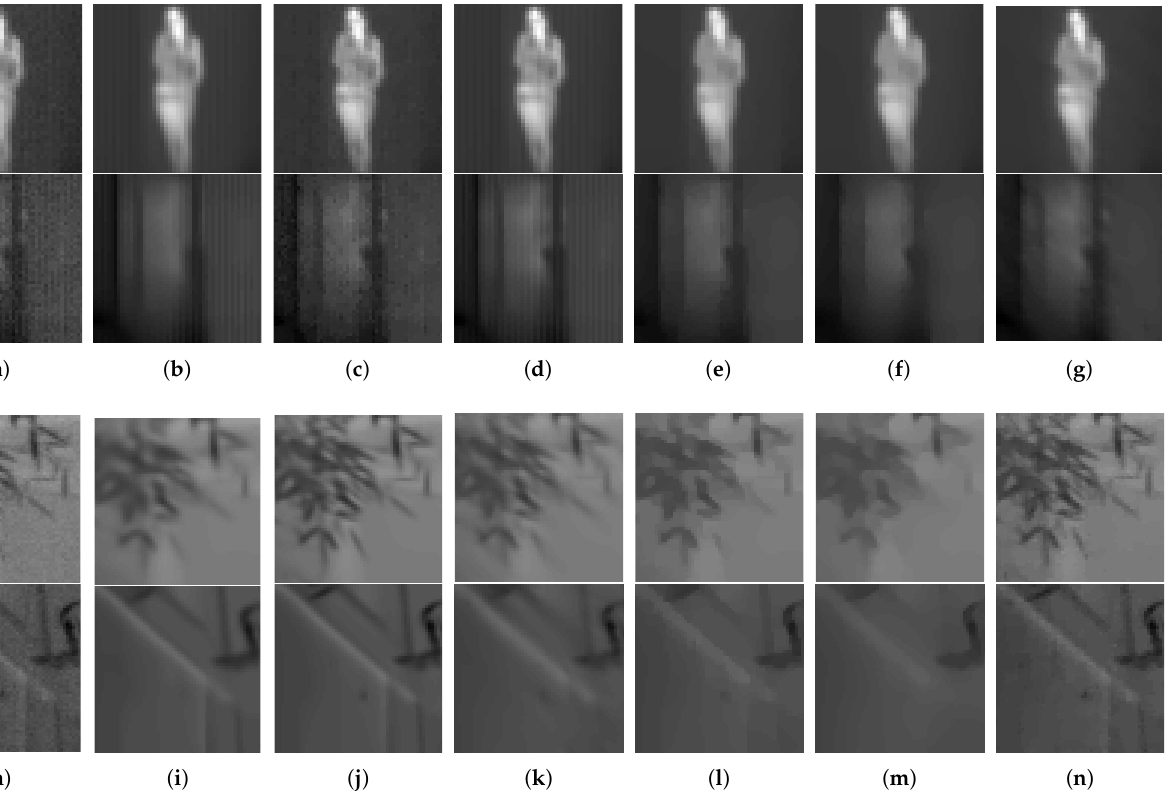
Figure 10. Final results of the conventional and proposed method. ( a , h ) Original degraded image of MORRIS ( top ) and KRISTO dataset ( bottom ); ( b , i ) BM3D; ( c , j ) Ochs et al.; ( d , k ) TWSC; ( e , l ) split Bregman with ATV; ( f , m ) split Bregman with ITV; ( g , n ) proposed method.